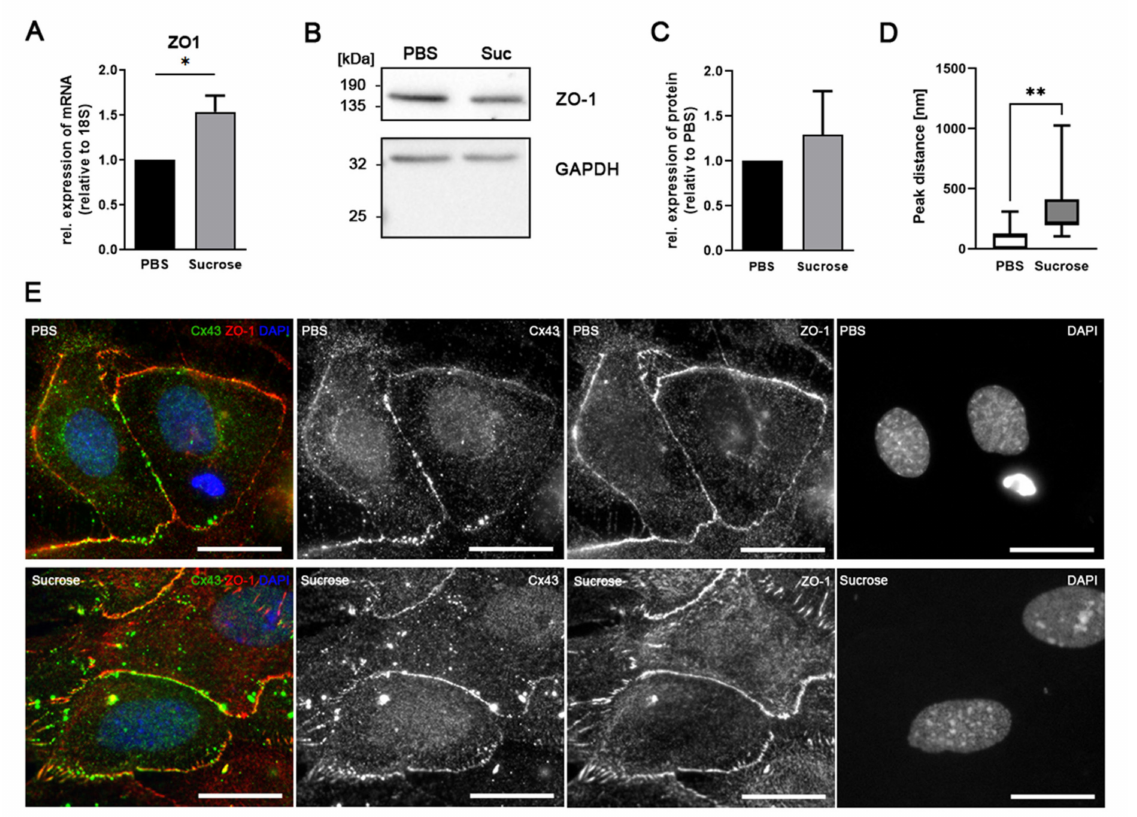
Figure 5. Hyperosmolar sucrose induces the transcription of zonula occludens (ZO) protein –1 at mRNA but not at protein level. ( A ) qPCR analyses of n = 3 experiments showed a significantly increased ZO–1 mRNA expression after sucrose-treatment (Suc) as compared to controls (PBS). Shown are means (+SEM). Statistical significance: * p < 0.05. ( B ) Immunoblotting with antibodies against ZO–1 showed no change in protein expression after sucrose-treatment. Im- munolabeling with antibodies against GAPDH served as loading control. Original images are shown in Supplementary File S1. ( C ) Quantification of immunoblots ( n = 4) confirmed the constant level of protein expression. ( D ) Quantification of immunofluorescent maxima in images of Cx43 and ZO–1 immunofluorescence. Whereas the fluorescence maxima at 488 nm and 568 nm excitation wave lengths were close-by in PBS-treated cultures, peaks were more distant in sucrose-treated cells, indicating less co-localization of the two detected proteins. Quantification of the peak distances (in nm) are shown as box plots with median and whiskers for minimum and maximum; ** indicate p = 0.0033). ( E ) The first panel on the left shows the merged immunofluorescence color images of Cx43 (green) and ZO–1 (red) proteins in PBS– and sucrose-treated astrocytes. Nuclei were labeled by DAPI (blue). Monochrome images show the immunofluorescence of Cx43 (second panel) and ZO–1 (third panel) as well as DAPI (fourth panel) separately. Although cell membranes and cellular contact sites are labeled by Cx43 and ZO–1 under both conditions, the distribution of the two immunosignals seems to change upon sucrose treatment. Scale bar: 20 µ